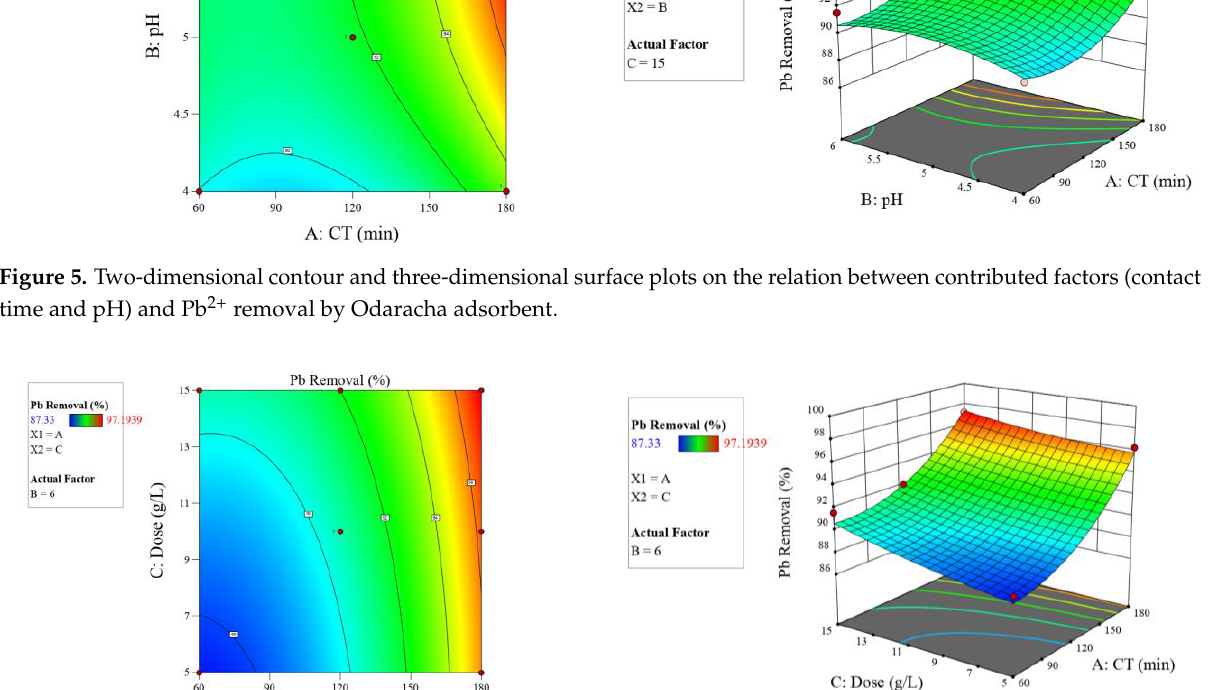
Figure 6. Two-dimensional contour and three-dimensional surface plots on the relation between contributed factors (contact time and dose) and Pb 2+ removal by Odaracha adsorbent.